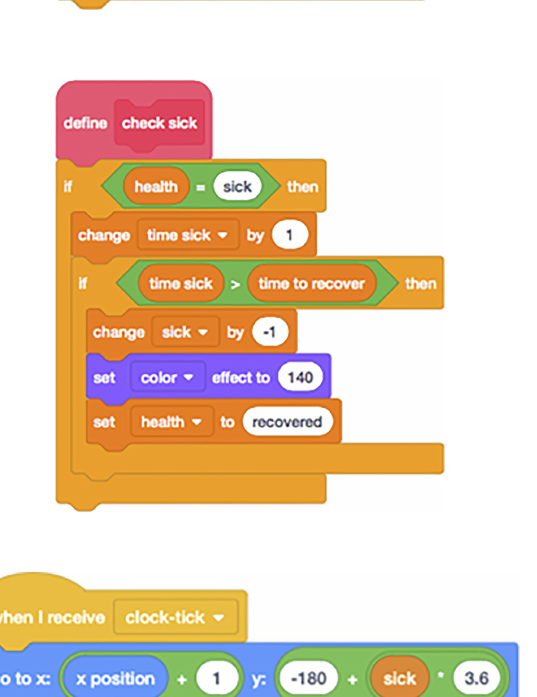
Figure 8. Coding blocks for illustrating transmission in simulation 1